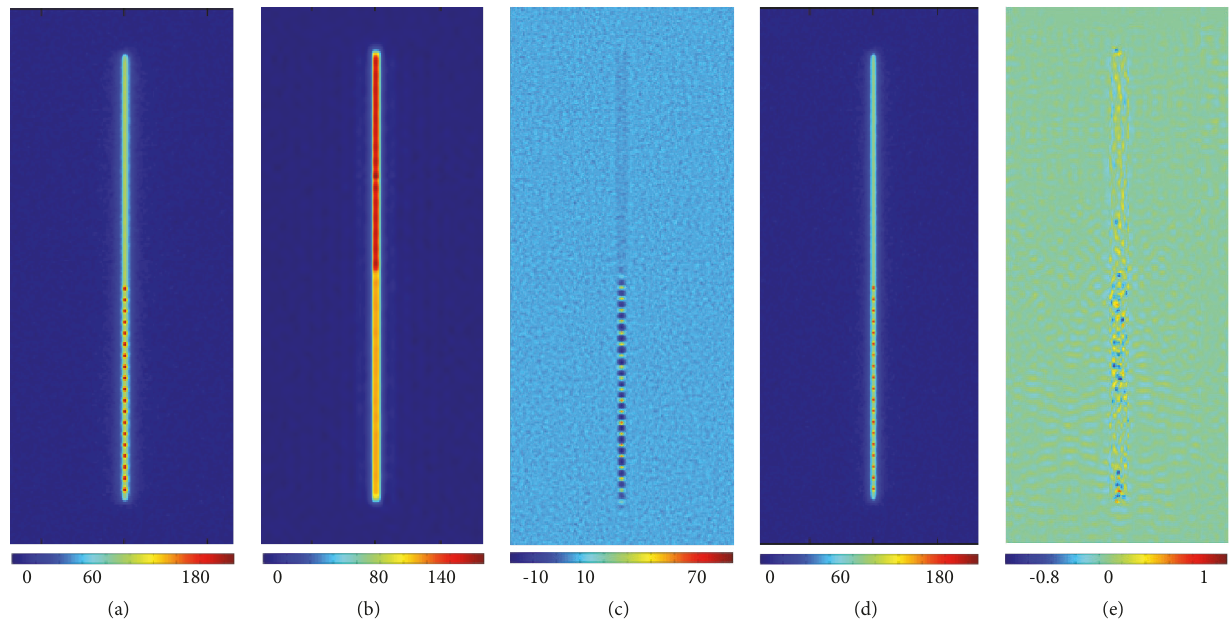
Figure 2: Results of thesimulated images obtained using MCAwithout convolution and denoising. (a)Original simulated image.(b)Cartoon layer. (c) Texture layer. (d) Reconstructed filaments without denoising. (e) Residuals.